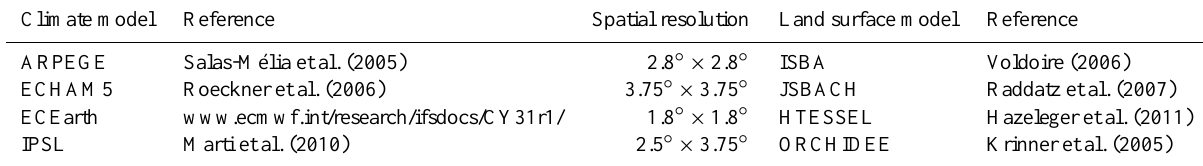
Table 1. List of climate models and associated Land Surface Models used in the first LUCID set of experiments.